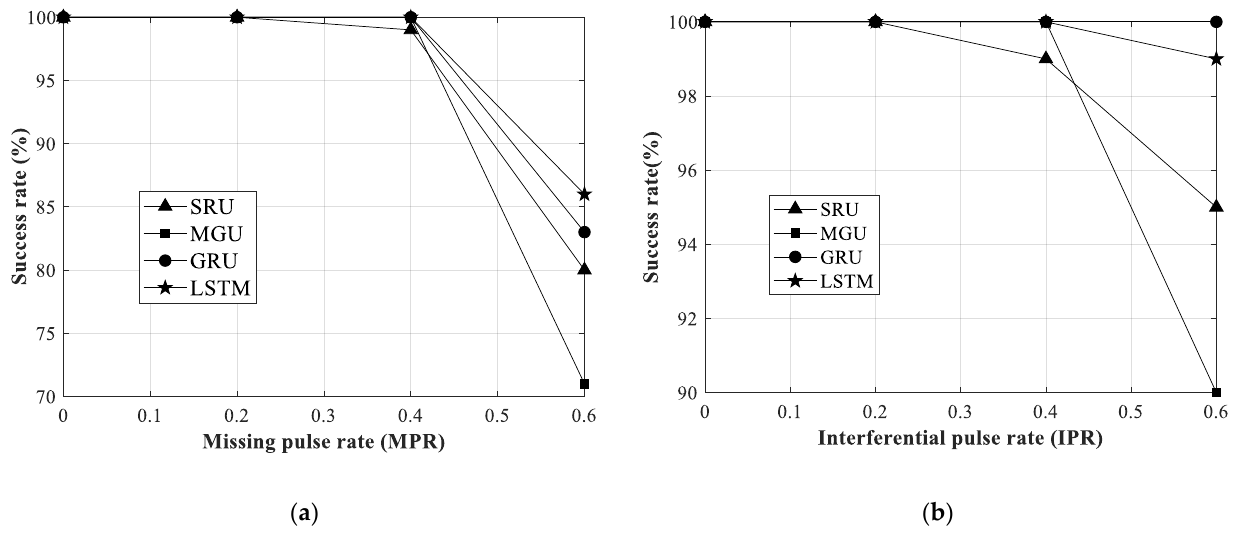
Figure 7. Influence of data noise on prediction task. ( a ) influence of MPR when IPR is 0.4; ( b ) influence of IPR when MPR is 0.4